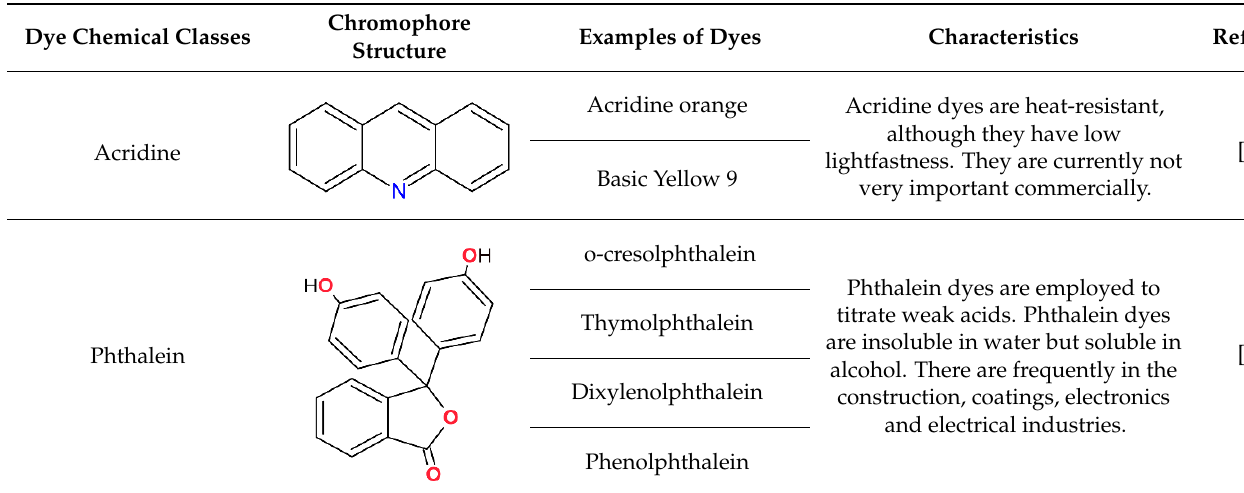
o-cresolphthalein Phthalein dyes are employed to titrate weak acids. Phthalein dyes are insoluble in water but soluble in alcohol. There are frequently in